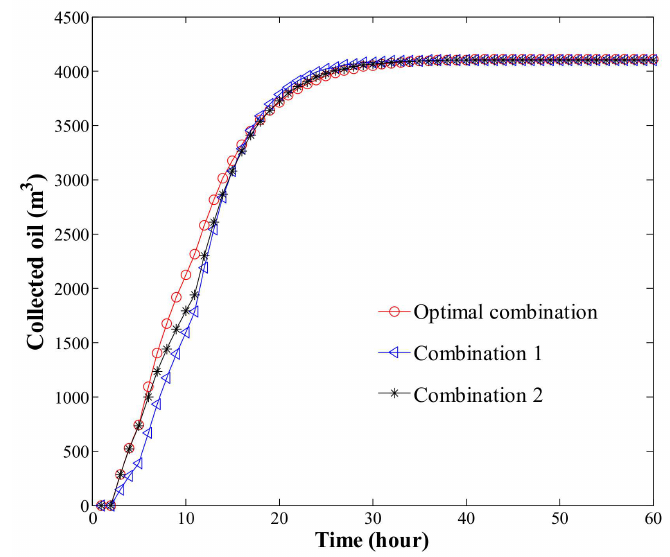
Figure 17. Performance of skimmer combination in oil